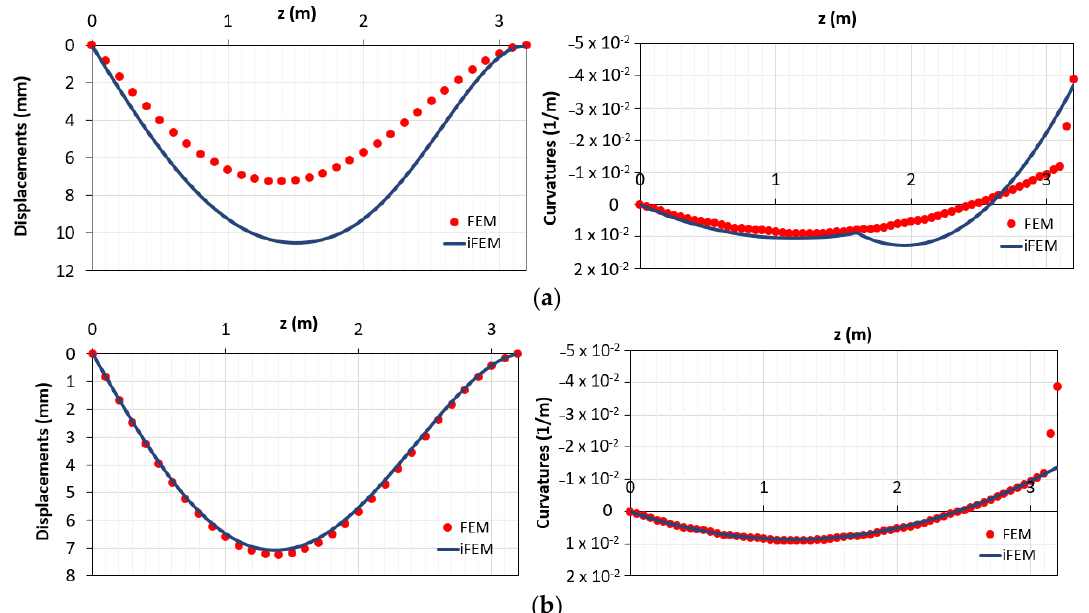
Figure 19. ( a ) Displacements and curvatures diagrams for the configuration “a”; ( b ) displacements and curvatures diagrams